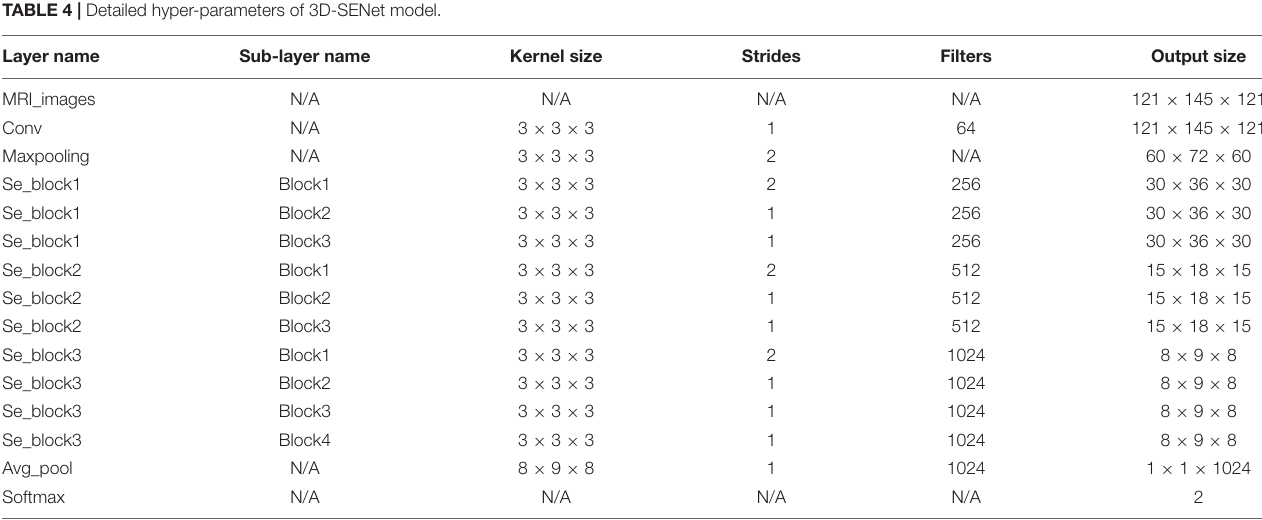
TABLE 4 | Detailed hyper-parameters of 3D-SENet